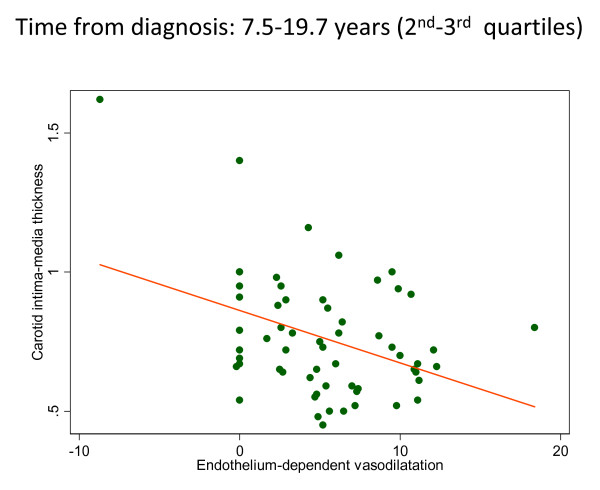
Scatterplot illustrating the relationships between FMD and carotid IMT in patients with RA and disease duration ranging between 7 and 20 years derived using linear regression analysis.